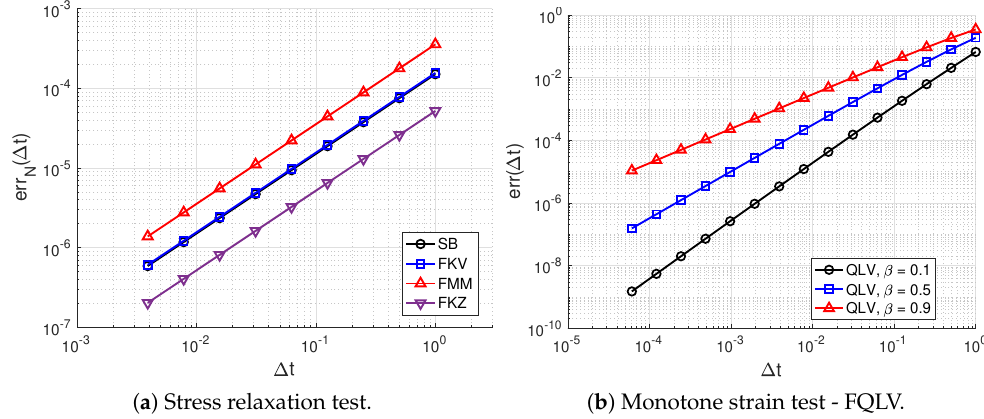
( b ) Monotone strain test - FQLV. Figure 3. Convergence analysis for the fractional viscoelastic models with known analyti- cal solutions: ( a ) a stress relaxation test with non-smooth step-strains and material parameters E E ( E ) = ( 1,1,1 ) and ( β ) = ( 0.3,0.7,0.1 ) yielding first-order convergence; ( b ) conver- 2 , 3 1 , 1 , β 2 , β 3 gence for the FQLV model with a fabricated solution of linearly increasing strains and material properties ( E , A , B ) = ( 1,1,1 ) and varying β . The slopes of the error curves are q ≈ 2 − β